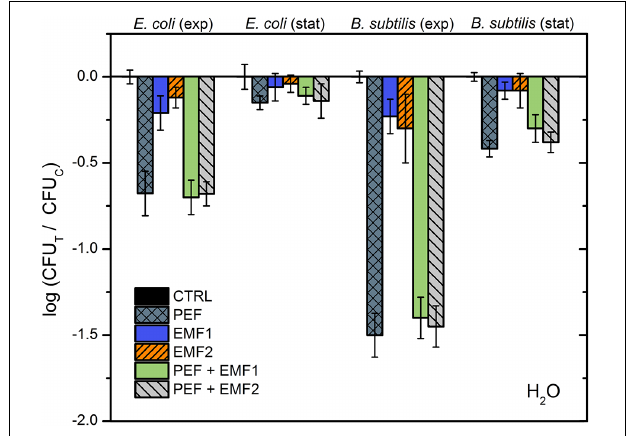
FIGURE 4 | Inactivation of E. coli and B. subtilis using different treatment protocols without NP, where PEF – 10 kV cm − 1 × 8 × 100 µ s; EMF1 – 3.3 T × 50, 0.25 Hz; EMF2 – 10 mT, 100 kHz, 2 min. The number of residual culturable cells in the samples after the PEF treatment (CFU T ) was compared with ones in the control samples without treatment (CFU C